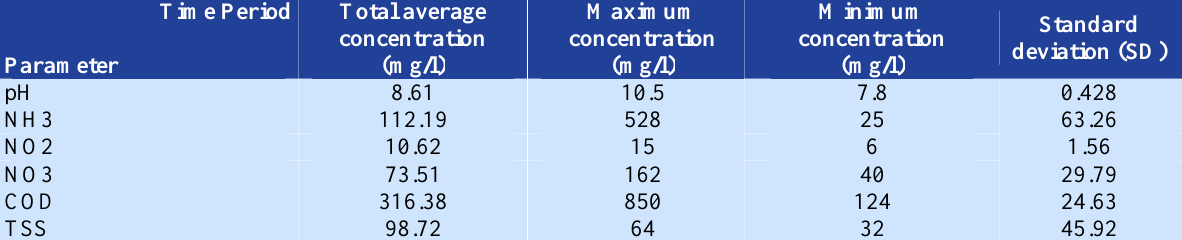
Table 2. Concentration of effluent pollutants during the total period of sampling Time